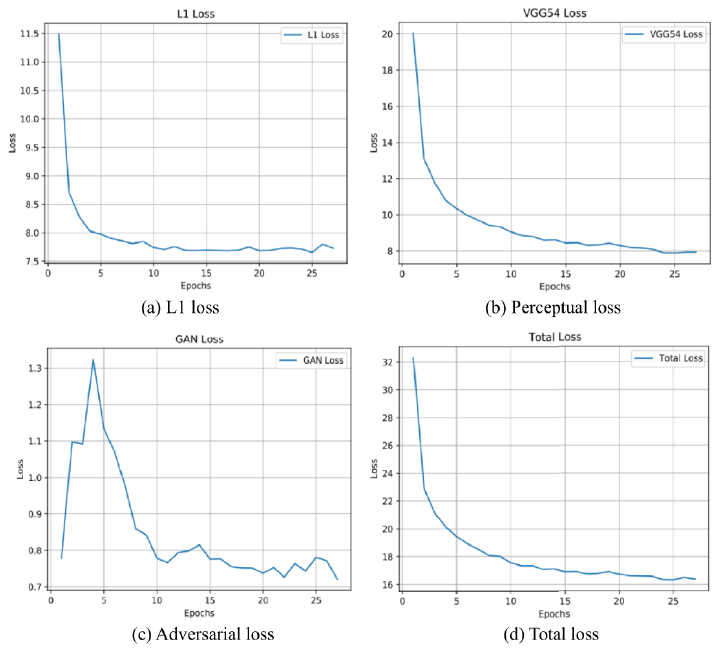
Figure 10. The training curves of the network.